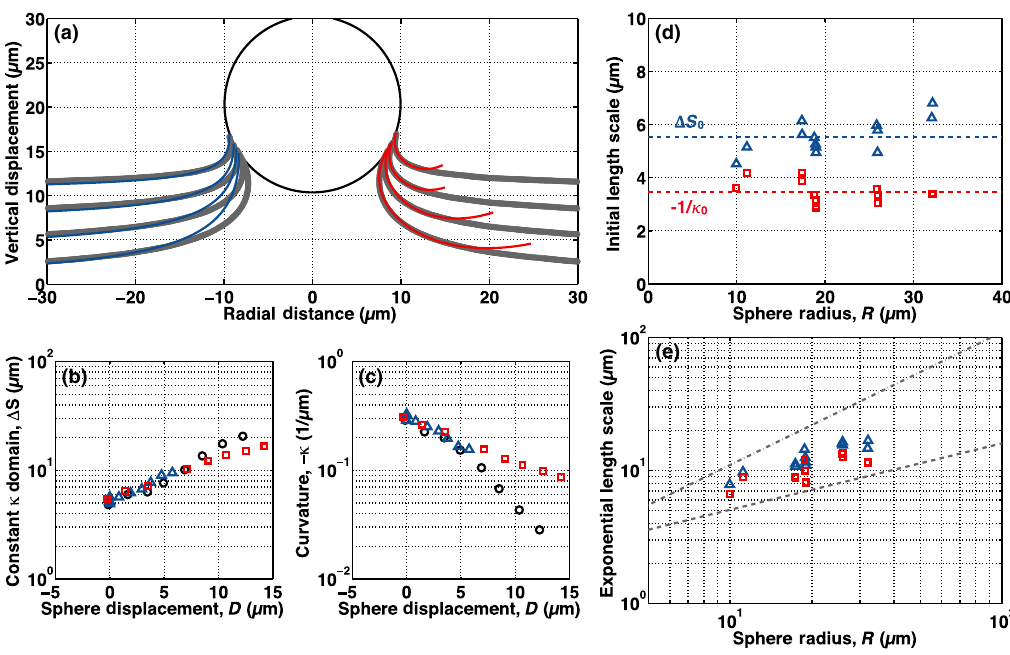
FIG. 2. Geometry of soft adhesive contact. (a) Mapped profiles from the same images shown in Figs. 1(b) – 1(e) (overlapping gray points). Predictions from elastic theory [17] are overlaid on the left (blue lines). Constant total curvature fits are overlaid on the right (red lines). (b) Size of the domain of constant curvature Δ S vs sphere displacement D for three example experiments with spheres of radius 10 . 0 μ m (black circles), 18 . 8 μ m (blue triangles), and 32 . 0 μ m (red squares). (c) Total curvature − κ vs D for the same three examples as in (b). (d) Plot of fit initial length scales vs sphere radius R : Δ S 0 (blue triangles, mean (cid:2) std dev ¼ 5 . 5 (cid:2) 0 . 6 μ m) and − 1 = κ 0 (red squares, mean (cid:2) std dev ¼ 3 . 5 (cid:2) 0 . 4 μ m). (e) Log-log plot of fit exponential length scales L Δ S (blue triangles) and L κ (red squares) vs R . Lines of slope 1 (dot-dashed line) and slope 1 = 2 (dashed line) are shown as guides to the